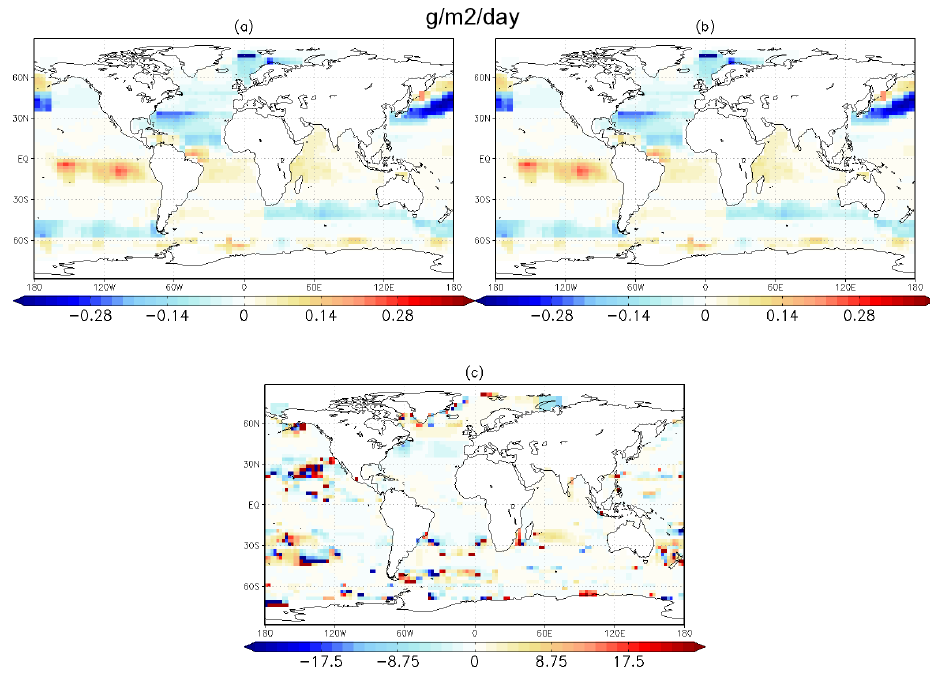
Fig. 4. Results of simulation experiment for ocean. (a) pseudotruth, (b) recovered fluxes, (c) difference in percentage between truth and recovered